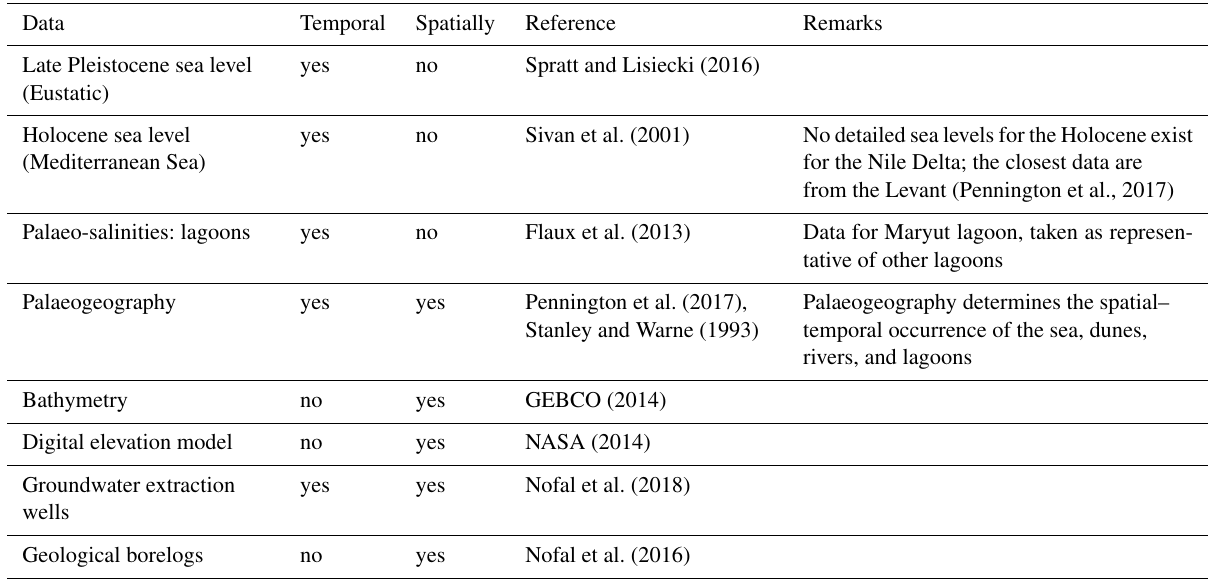
Table 2. References to data used for spatially and/or time-varying input to the model.